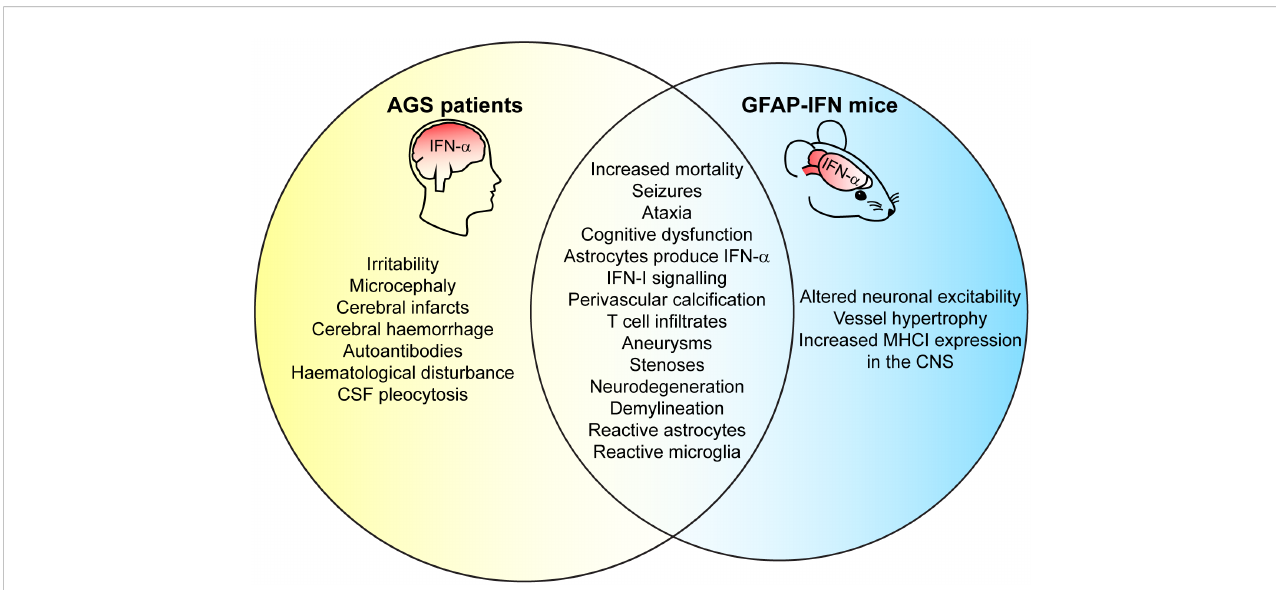
FIGURE 3 GFAP-IFN mice recapitulate clinical and pathological features of patients with AGS. Venn diagram showing overlap between clinical CNS symptoms and neuropathology observed in the GFAP-IFN mice and patients with AGS. Features that do not overlap and/or have yet to been shown in mice or in patients are also